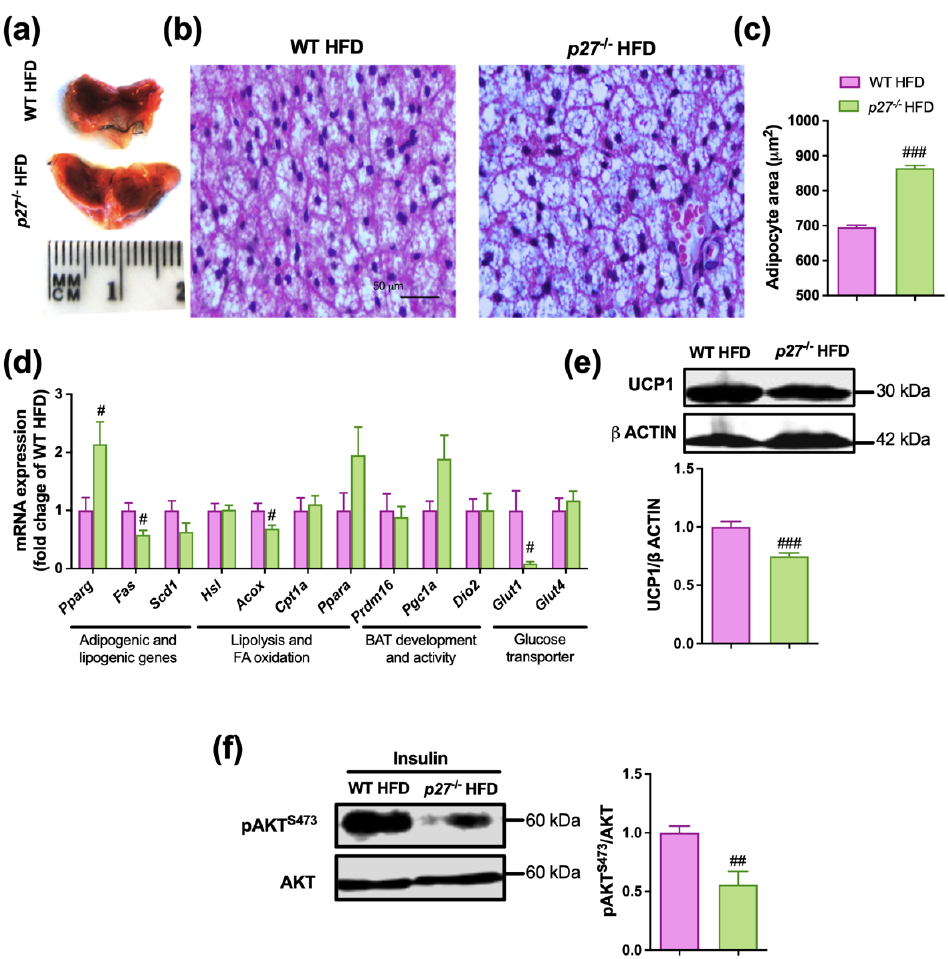
Figure 4. iBAT of p27 -/- HFD mice exhibits whitening and impaired insulin signalling. ( a – c ) Repre- sentative macroscopic ( a ) and histological images ( b ) and adipocyte area quantification ( c ) of iBAT in WT and p27 -/- mice fed with HFD for 10 weeks. ( d ) mRNA expression analysis of genes with relevant roles in iBAT function/metabolism in WT and p27 -/- mice fed with HFD for 10 weeks. ( e ) Representative image and densitometric quantification of Western blot analysis of UCP1 in iBAT of WT and p27 -/- mice fed with HFD for 10 weeks. ( f ) Representative image and densitometric quanti- fication of Western blot analysis of pAKT S473 /AKT in iBAT of insulin-stimulated WT and p27 -/- mice fed with HFD for 10 weeks. Data are expressed as mean ± SEM ( n = 5–9). # p < 0.05, ## p < 0.01, ### p < 0.001 vs. WT HFD.